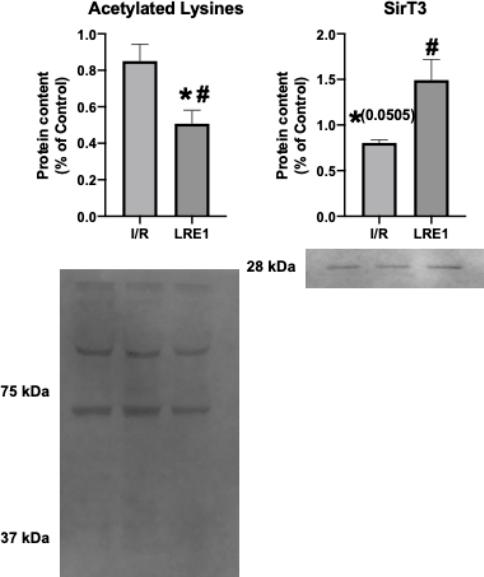
Figure 8. Hepatic mitochondrial protein acetylation status and NAD + -dependent deacetylase sirtuin 3 (SirT3) quantification by Western blot. Data are means ± SEM of 4 independent experiments. SirT3, Sirtuin 3. * indicates a statistically significant difference vs. Ctl; # indicates a statistically significant difference vs. I/R.